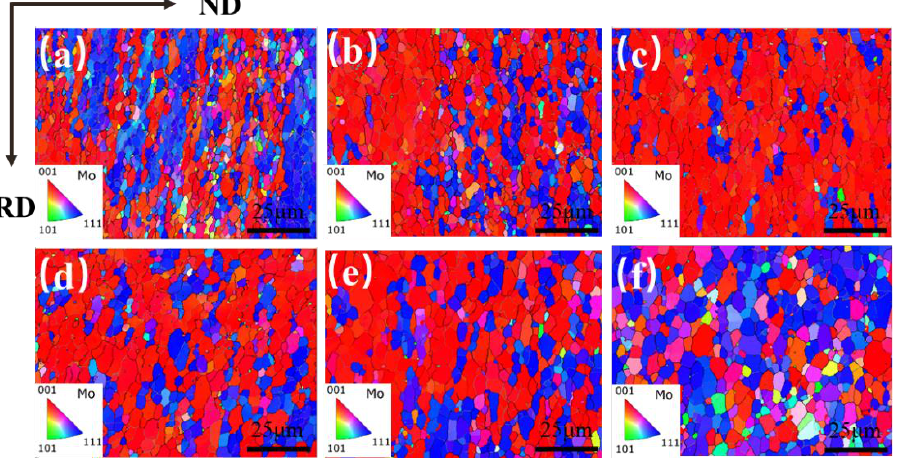
Figure 17. Grain orientation (IPF) maps of Mo − 1.5wt% ZrO 2 molybdenum alloy at a strain rate of 0.01 s −1 : ( a ) 1000 °C, ( b ) 1100 °C, ( c ) 1200 °C, ( d ) 1300 °C, ( e ) 1400 °C, ( f ) 1500